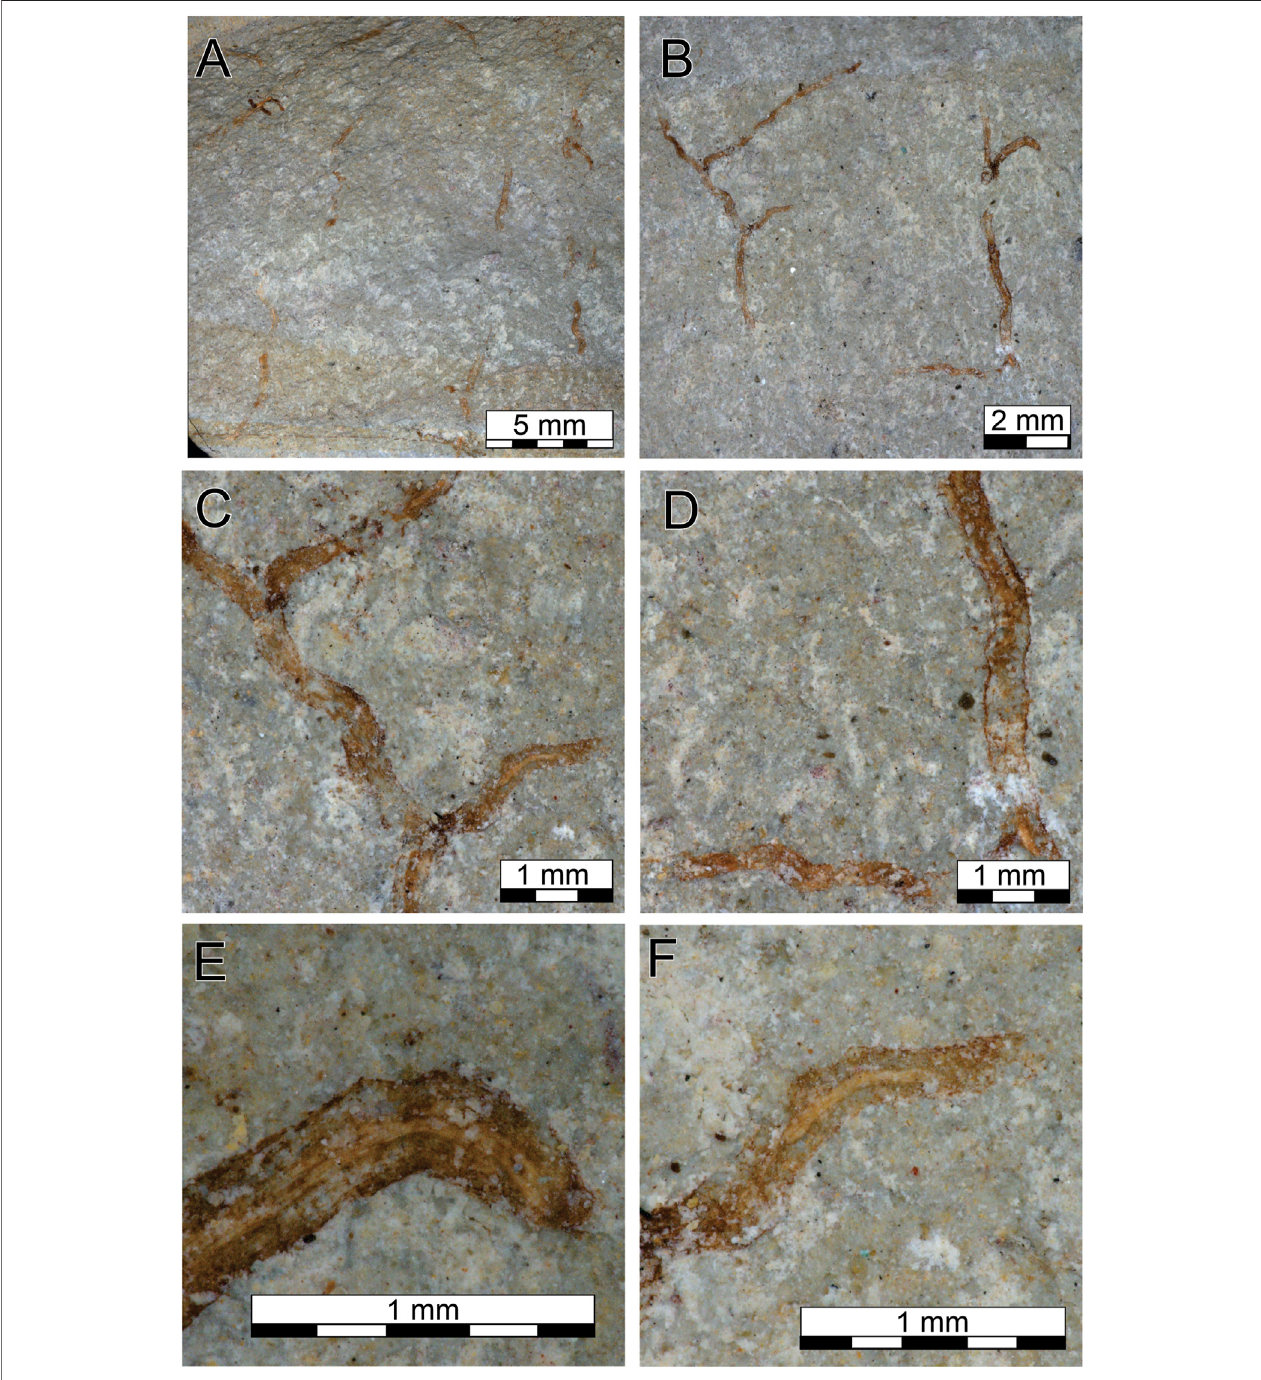
FIGURE 4 | Ladariophyton veinosa . (A,B) The complete fossil. (C) Details of the branching. (D) Details of the edge. (E,F) Details of the thickness of the longitudinal structure.